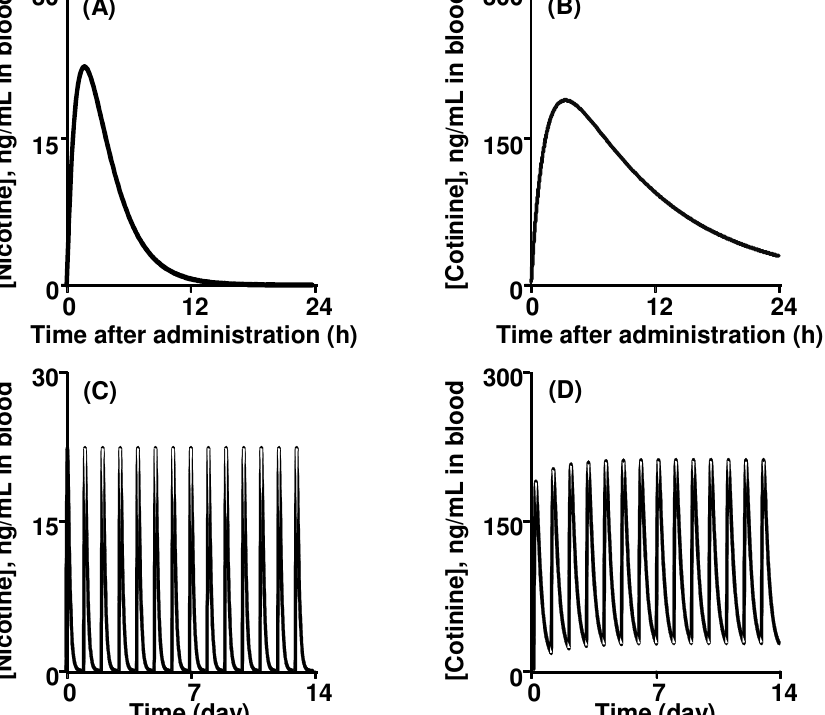
Figure 6. Nicotine (A, C) and cotinine (B, D) concentrations modeled in humans after single (A, B) or multiple (C, D) oral administration of nicotine (1 mg/kg/day) estimated using the PBPK model. Only limited accumulation was observed for multiple